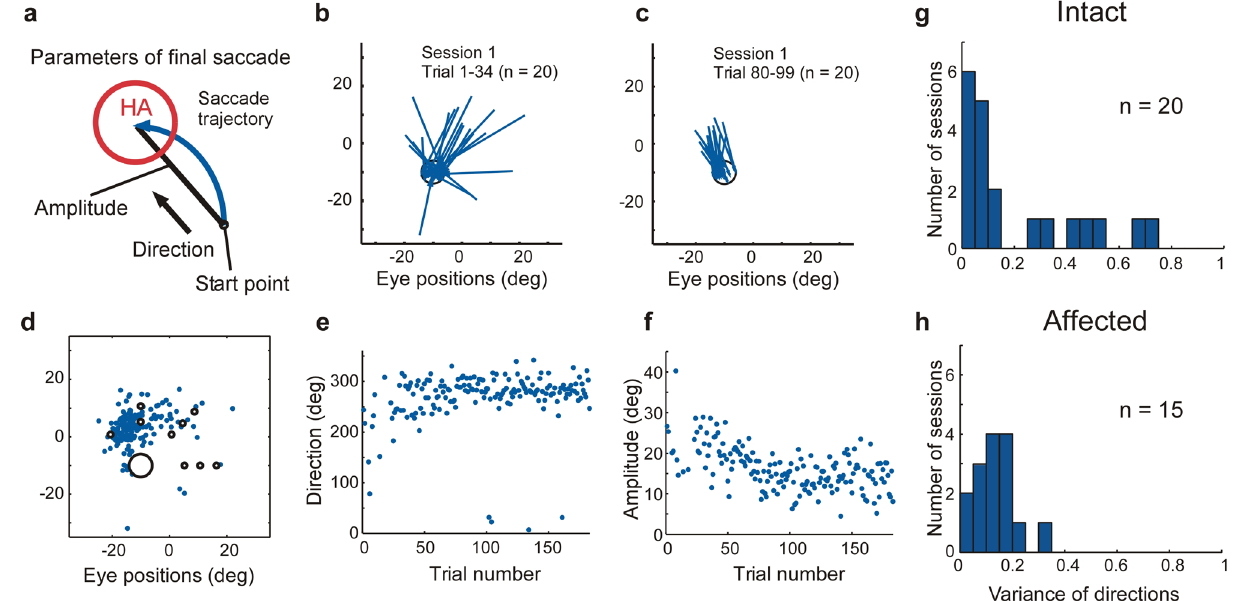
Figure 5. Learning the matrix of the final saccades that preceded CS presentation. ( a ) Schematic illustration of a final saccade capturing the HA and its parameters. ( b ) and ( c ) Vectors of final saccades when the CS was presented in the lesion-affected field. The final saccades of the 20 successful trials among the trial No. 1–34 ( b ) and trial No. 80–99 ( c ) of a session which is the first session in Fig. 4a, b. A final saccade was characterized by three parameters [start point ( d ), direction ( e ) and amplitude ( f )] of the vector from its onset location to its offset in the HA ( a ). ( d )–( f ) Saccade parameters in a session, shown in ( b ) and ( c ). Start point ( d ), direction ( e ) and amplitude ( f ) of the final saccades. ( g ) and ( h ) Distribution of variance of direction of the final saccades in multiple sessions. ( g ) CS in the intact field and ( h ) lesion-affected (Fig. 4d–f and STable 1 and 3). The range of Trial index were 49–97 in monkey U and 23–73 in monkey Tb. In the present study, it was not possible to conduct quantitative comparisons of the learning efficiency between CS presentation in intact vs lesion-affected visual fields because the task difficulty was not balanced between the two conditions (see Supplemental information: Limitation of this study). The condition in which the CS was omitted was also tested for some trials in sessions where the CS was being presented to the lesion affected visual field. Again, under these conditions the animals failed to learn the HA location (light-grey background in Fig. 4g, Wilcoxon rank sum test, p > 0.05, in 2/2 sessions in monkey U and in 2/2 sessions in monkey Tb). After the visual CS was re-instated, the animals were again able to discover the location of the HA (white background in Fig. 4g, Wilcoxon rank sum test, p < 0.05, in 2/2 sessions in monkey U and in 2/2 sessions in monkey Tb). These observations replicate the finding that for instrumental learning to occur, the near immediate visual CS presented to the lesion-affected field in this condition is also essential, rather than the delayed juice reinforcement. Taken together, these data show that for both subjects the instrumental learning required to locate an unseen area could be successfully accomplished when a secondary reinforcing visual CS was presented either to their intact or to their lesion-affected visual field. Importantly the features of the learning performance in either case was qualitatively comparable. Targets of reinforcement. We next addressed the issue of what aspects of saccadic eye movements in our search task were being reinforced by the visual CS. To force the animal to learn the HA location in a representa- tion in the non-retinocentric coordinate space (either head-centered or allocentric), each trial the search for the HA was started from a different randomly assigned location. This prevented a retinocentric solution based on learning a vector of eye movements from a fixed starting position. In our task, optimal performance in the non- retinocentric coordinate frame would be for the monkey to make a single saccade from the initial, randomly determined start location directly to the HA. However, in practice, this response rarely occurred, even after the location of the HA was well known (see trial 96 in Fig. 3c and trial 176 in Fig. 4c). We found that the final eye movements entering the HA (Fig. 5a) tended to converge on one or two vectors in each session (i.e. the ampli- tude and direction of final saccades became increasingly consistent; Fig. 5). For example, in the session shown in Fig. 5b–f, the preponderance of final saccades entered the HA from above (median saccade direction = 282°). The ‘variance in direction’ in Fig. 5g, h was defined as V = 1 − R (R: length of mean saccade direction vector, 0 ≤ V ≤ 1, see Supplementary information). Here, a value of 1 indicates a uniform dispersion from all possible directions, while a value of 0 would represent entry from a single direction. The variance of saccade direction in the case of Fig. 5e was 0.15 and in a majority of cases (13 out of 20 in the intact field and 13 out of 15 in the affected field), the values were < 0.2 (Fig. 5g, h). In both conditions with CS in intact and affected visual field, standard deviation